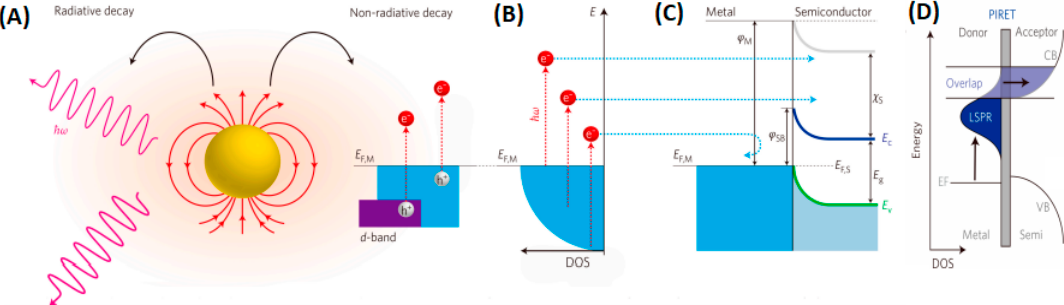
Figure 3. ( A ) High-energy resonant state decay in two possible form: Re-emission of photons or the generation of energetic charge carriers; ( B ) excitation electron from occupied energy level to a level above the Fermi energy; ( C ) hot electron overcoming the Schottky barrier and injected to the conduction band of the neighboring semiconductor; ( D ) plasmon-induce resonance energy transfer. (Reproduced with permission from MDPI [28]).